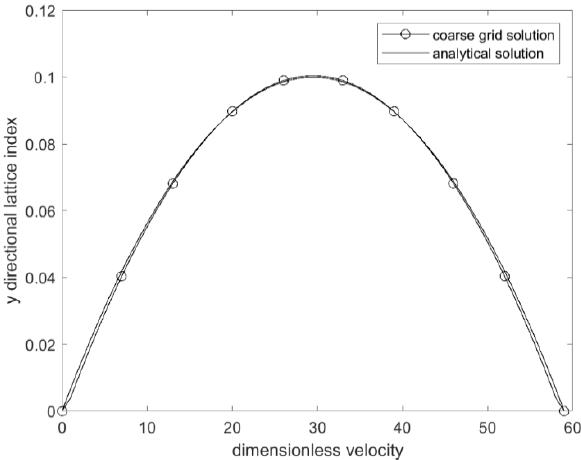
Figure 9. Comparison of analytical solution and proposed solution at x = 30.